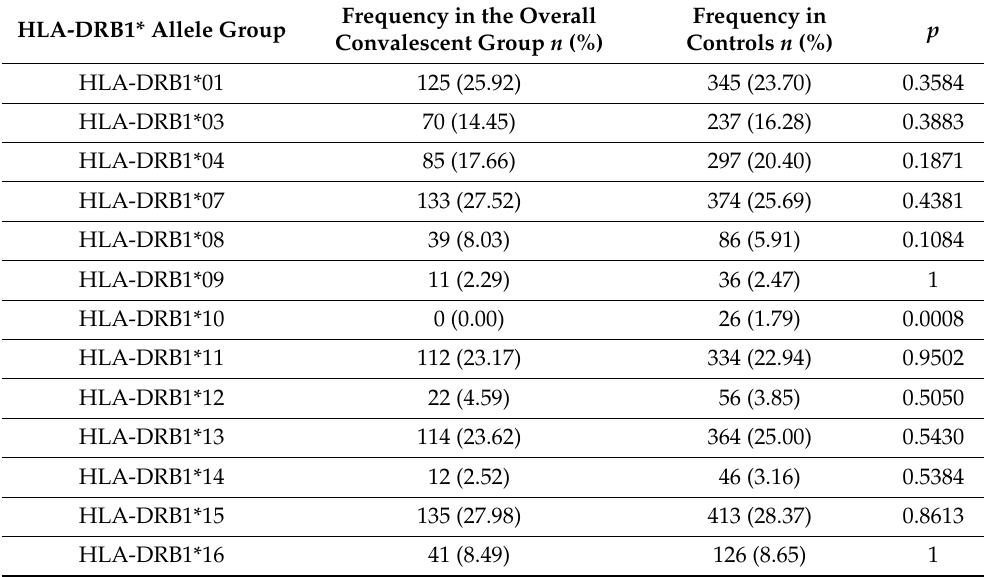
Table 3. Frequency of HLA-DRB1* allele groups among the overall COVID-19 convalescent group ( n = 484) compared with controls ( n =